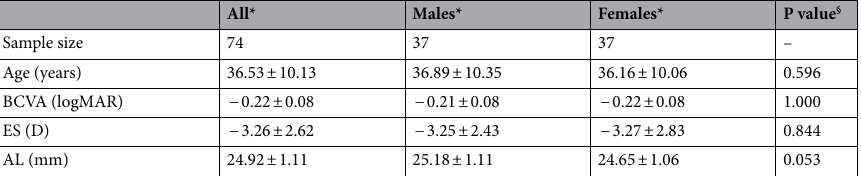
Table 1. Patient demographics. BCVA best corrected visual acuity, ES equivalent spherical, AL axial length. *Mean ± standard deviation. § Mann–Whitney U